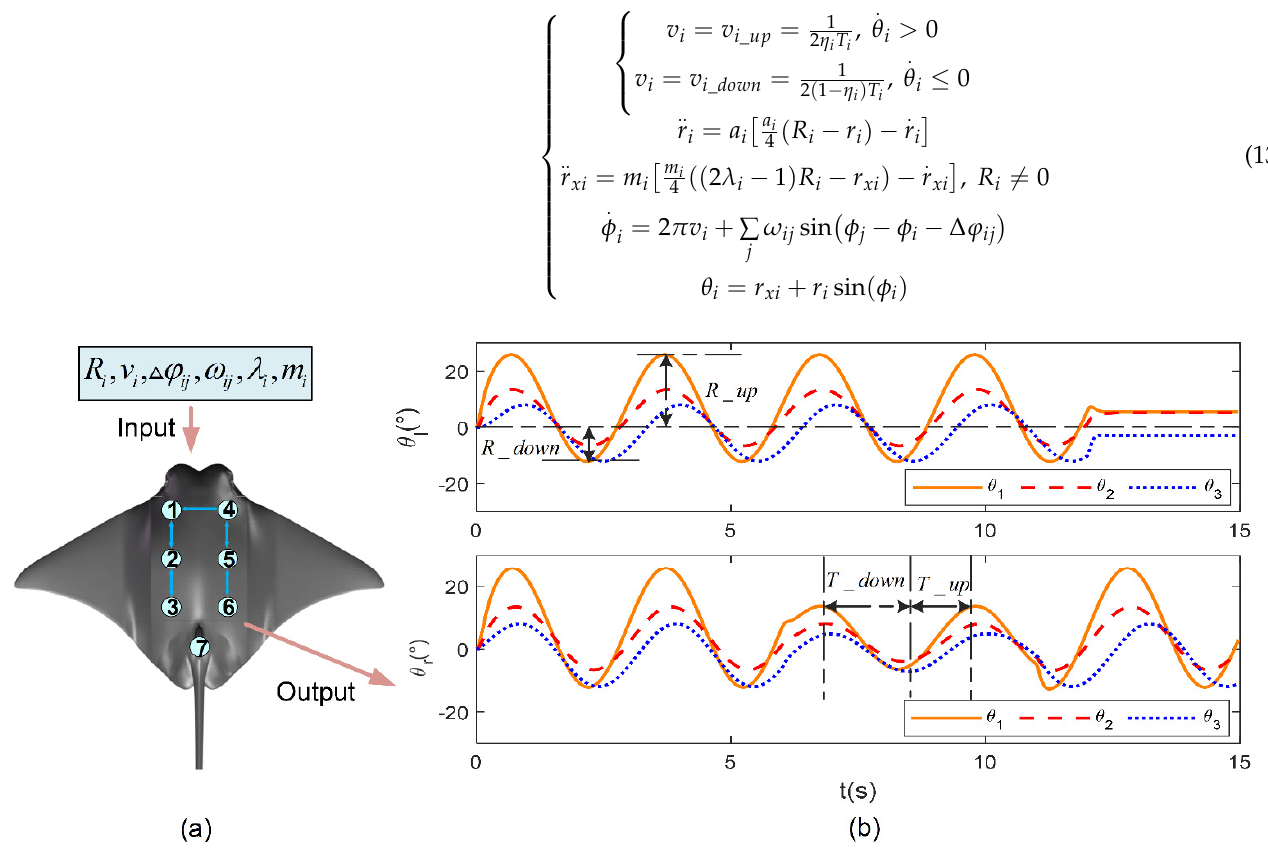
Figure 5. Motion control simulation of a manta ray robot based on the CPG network. ( a ) A graph of the topology network connection form; ( b ) A graph of the CPG network output. Table 1. Parameters of the phase oscillator model.